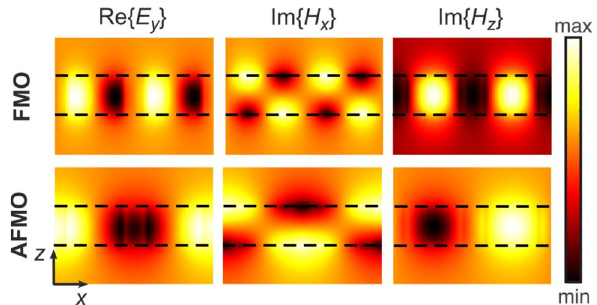
Figure 3. Profiles of the dominant field components for the FMO and AFMO supermodes of Fig. 2 on the y = �/ 4 plane. Due to the strong field confinement in the high-index silicon metasurface both supermodes are quasi-symmetric with respect to the z = h / 2 plane with even electric field parity (even quasi-TE modes). The H z profile for the AFMO supermode shows the characteristic odd symmetry with respect to the x = �/ 2 axis.